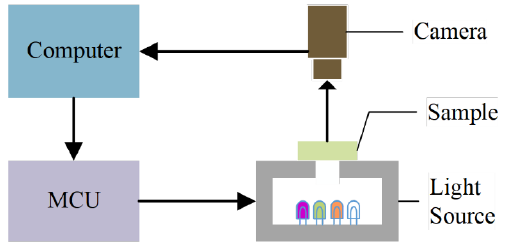
Figure 1. Schematic diagram of color recognition system of transparent plastic based on multi- wavelength transmission spectrum.